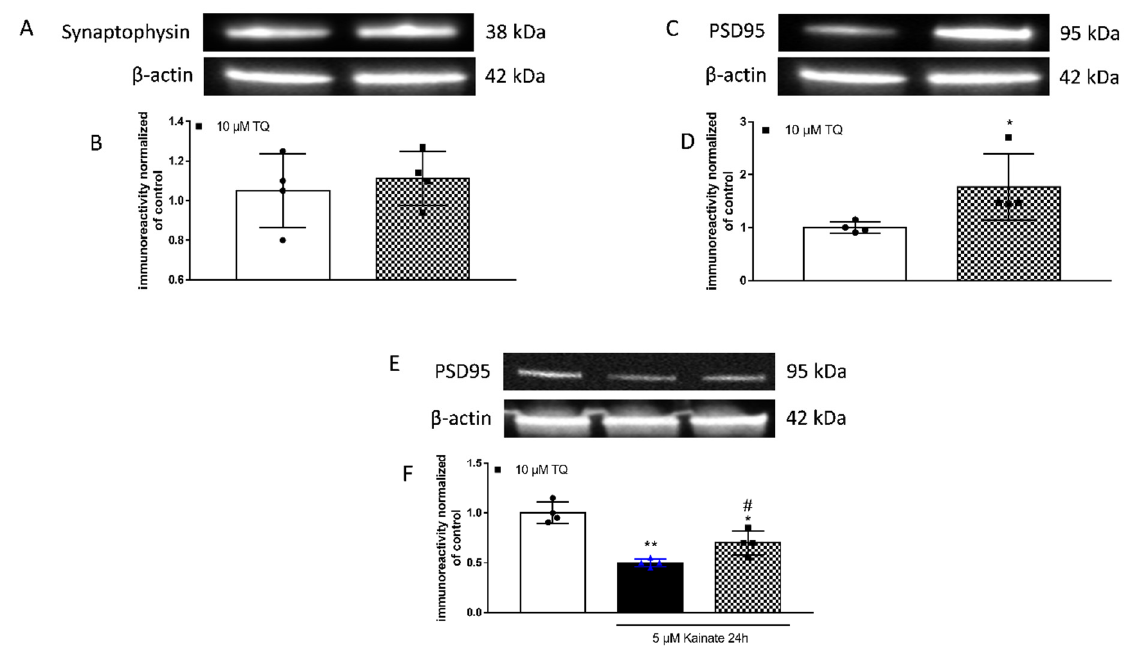
Figure 1. Effects of TQ on synaptophysin and PSD95 in organotypic hippocampal slice cultures in basal condition. Illustrative blots using antibodies directed against synaptophysin ( A ) and PSD95 ( C , E ) and β -actin. (B-D-F). Quantitative analysis of immunoreactive bands shows no significant changes in levels of synaptophysin ( B ), but a significant increase in PSD95 ( D ) induced by application of 10 µ M TQ for 24 h in basal condition. TQ is able to prevent the decrease in PSD95 induced by kainate. Dot blots show the results of four experiments from independent slice preparations and each dot is the pool of four slices. * p < 0.05 vs. CRL. (Unpaired t -test in ( B , D )) and * p < 0.05, ** p < 0.01 vs. CRL, # p < 0.05 vs. kainate. (ANOVA + Tukey’s w -Test in ( F )).